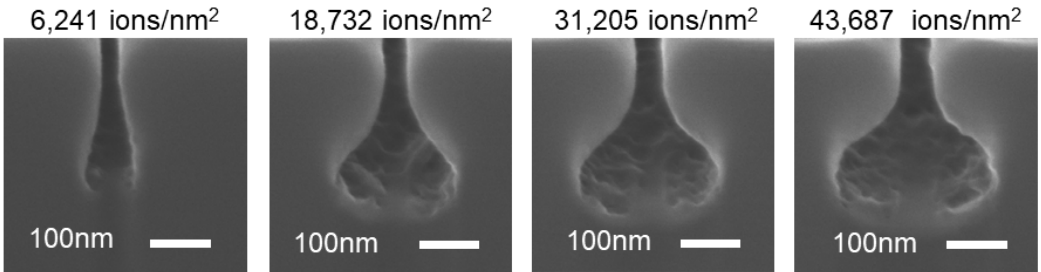
Figure 3. SEM images of the etched Si nanostructures using HIBEE with the same energy by increased influences of helium ions. A larger influence leads to a larger percentage of amorphization and thus more etching; however, the maximum depth of the cavity is almost constant.